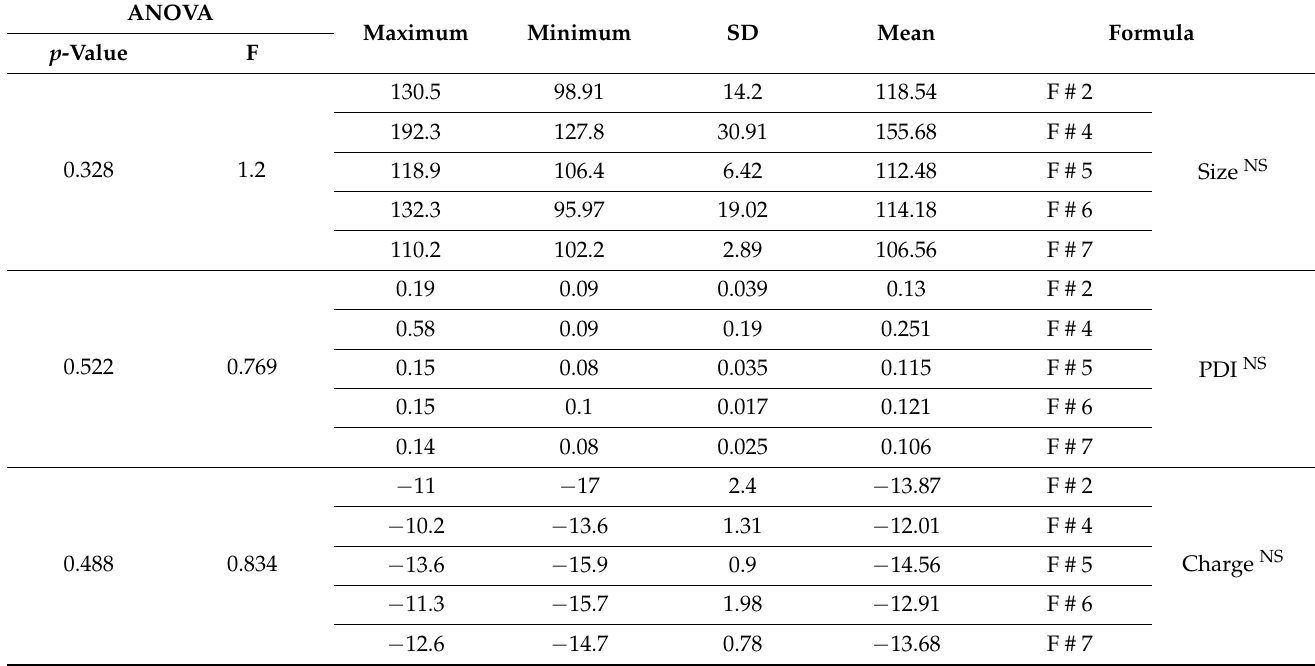
Table 2. Effect of CAP amount on (particle size, PDI, and Zeta